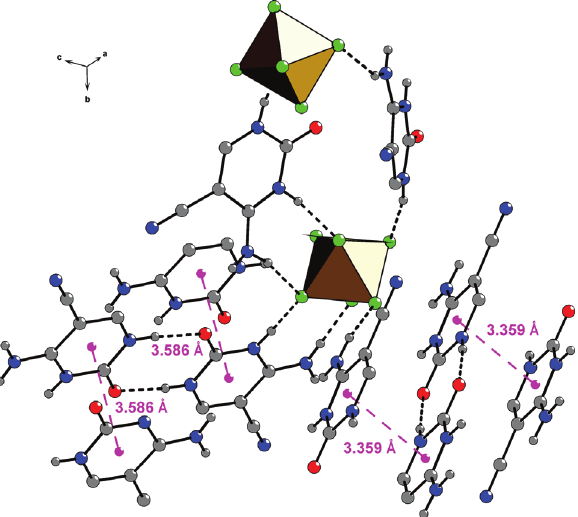
Figure 2. Stacking diagram of 1 presenting the π – π interactions between the 2-aminopyrimidinium cations. The hydrogen atoms on aromatic rings have been omitted for clarity.